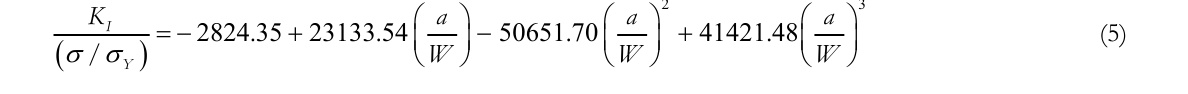
Figure 9: A typical plot of K for various